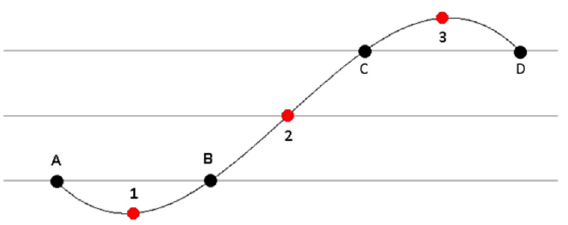
Figure 11. Calculation of the elevations with Bicubic Interpolation from points A, B, C and D.